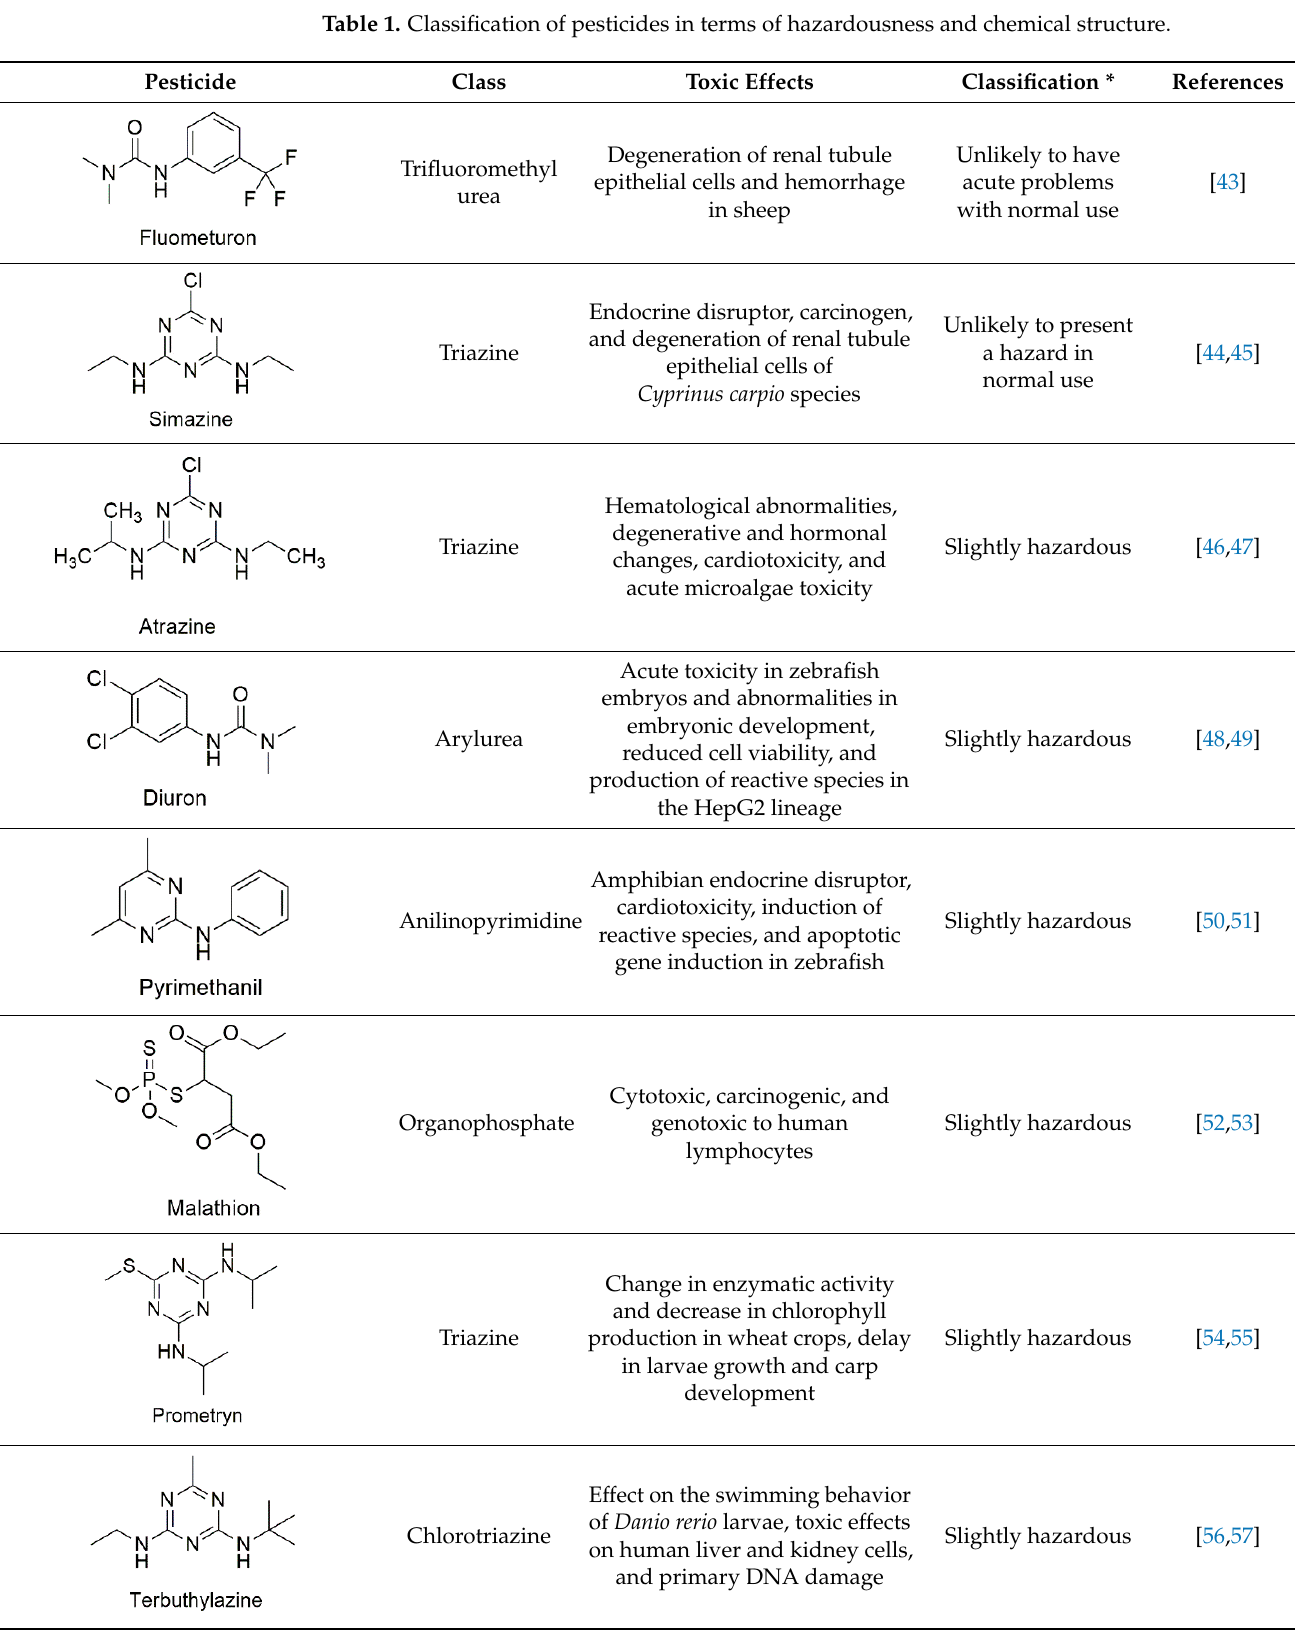
Table 1. Classification of pesticides in terms of hazardousness and chemical structure.